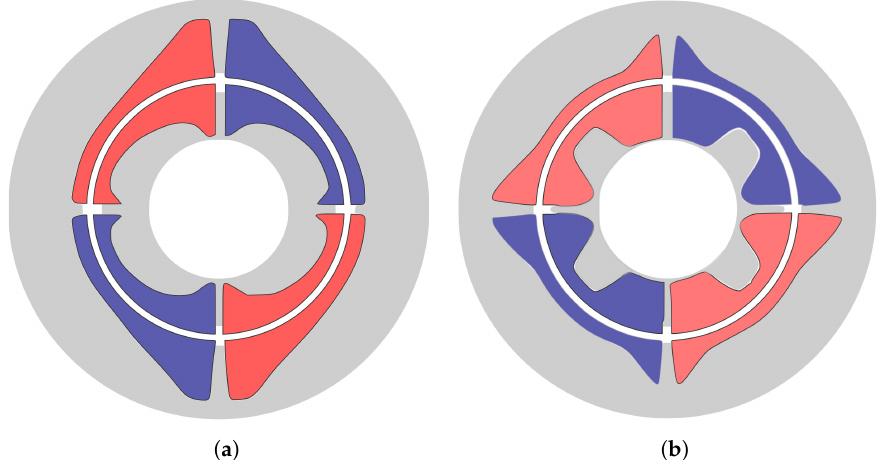
Figure 9. Resulting geometry from parametric shape optimization for rectangular reference torque. ( a ) Polynomial parametrization. ( b ) Spline